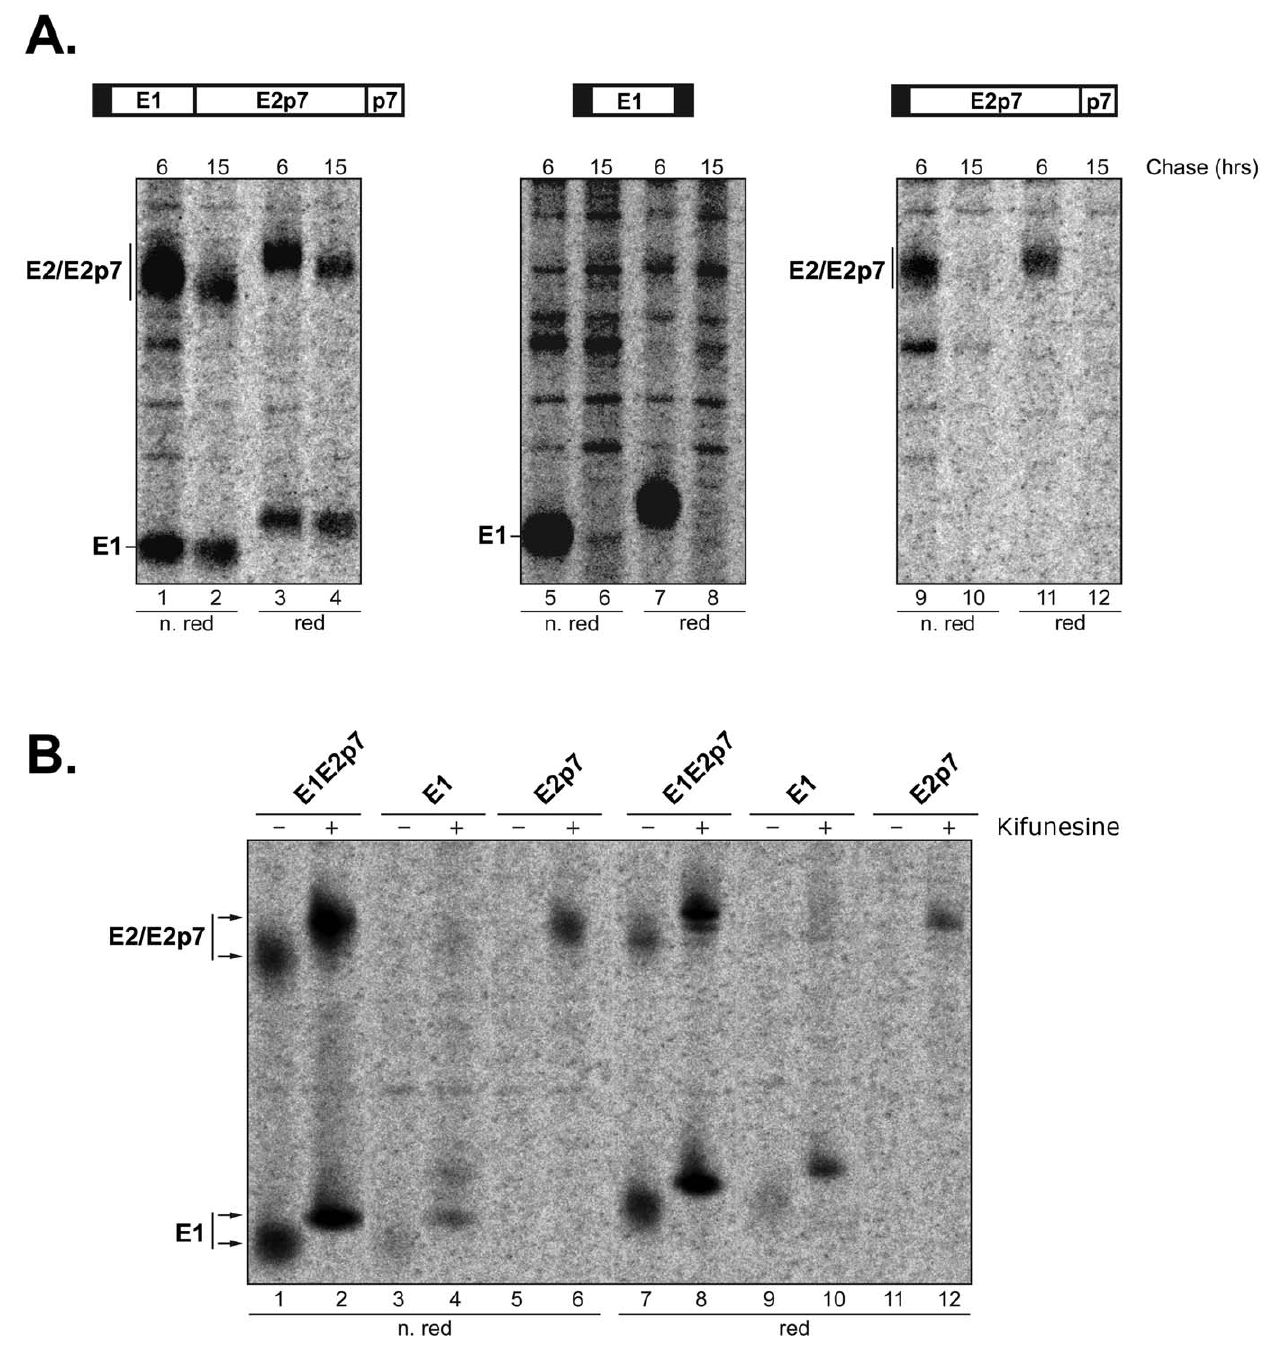
Figure 4. E1 and E2 stability in CHO stably trasfected cells. (A) CHO cells expressing E1, E2p7 or E1E2p7 were pulse-labeled with [ 35 S]- methionine and –cysteine for 20 min and chased for 6 and 15 hrs. PNSs were immunoprecipitated with the CBH-111 anti-E1 monoclonal antibody (central panel) or the CBH-7 anti-E2 monoclonal antibody (lateral panels). Samples were analyzed on 10% SDS-PAGE in non-reducing (lanes 1, 2, 5, 6, 9, 10) or reducing (lanes 3, 4, 7, 8, 11, 12) conditions. (B) CHO cells stably transfected with E1, E2p7 or E1E2p7 were pulse-labeled with [ 35 S]- methionine and –cysteine for 20 min and 15 hrs. During the pulse- and chase-time, the medium was supplemented with ( + ) or without ( 2 ) 20 m M kifunesine. PNSs were immunoprecipitated with the CBH-111 anti-E1 antibody (lanes 3, 4 and 9, 10) or the CBH-7 anti-E2 monoclonal antibody (lanes 1, 2, 5, 6, 7, 8, 11, 12). Samples were analyzed on 10% SDS-PAGE in non-reducing (lanes 1–6) or reducing (lanes 7–12) conditions.